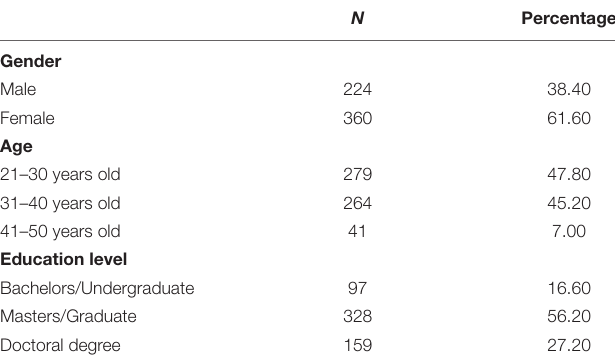
TABLE 1 | Demographic information of the